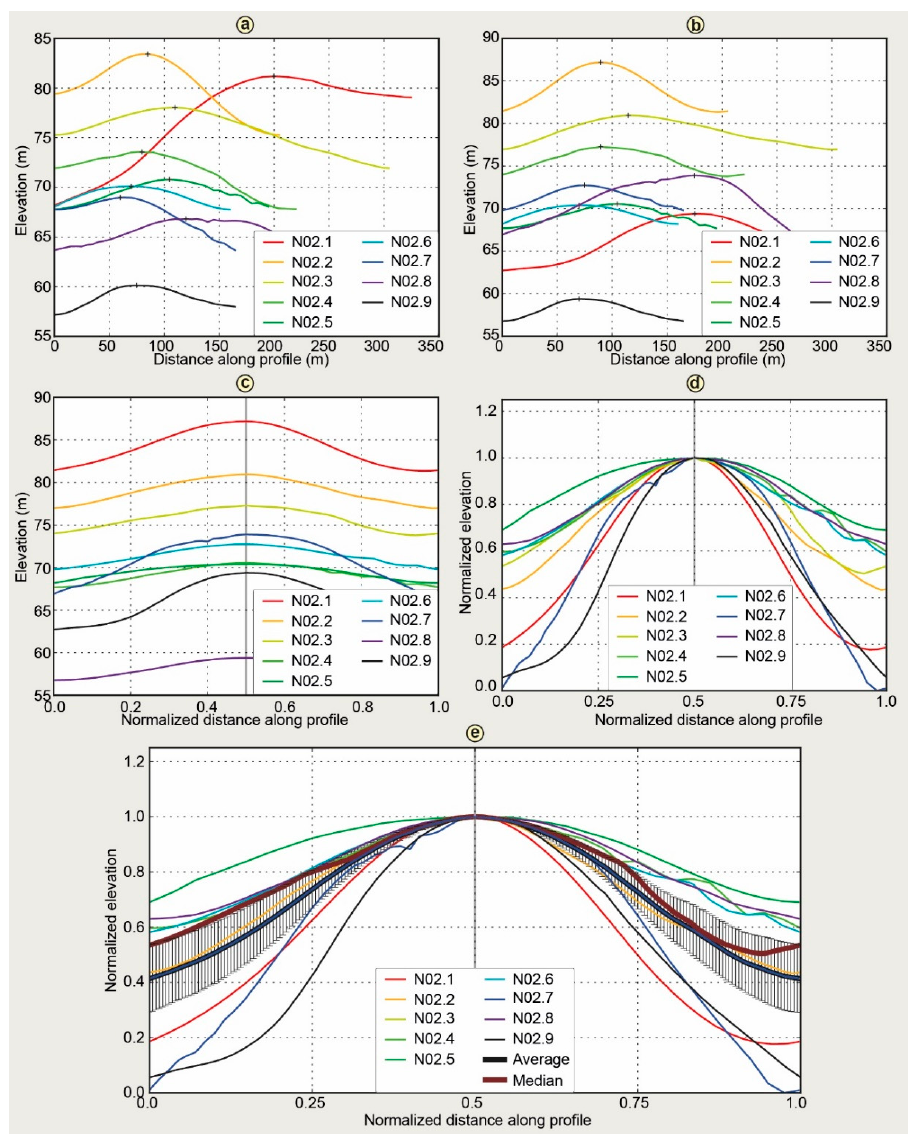
Figure 4. Steps for calculating a stacked ridge plot from well-defined ridges along profile N02: ( a ) Original trough-peak-trough segments extracted from the elevation profile; ( b ) Rotated ridge crests with its highest (post-rotation) elevation to mark a structural peak (shown with +); ( c ) Normalized ridges in x ; ( d ) Normalized ridges also in y and stacked at their peaks; and ( e ) Added elevation average with error bars (±1 standard deviation).